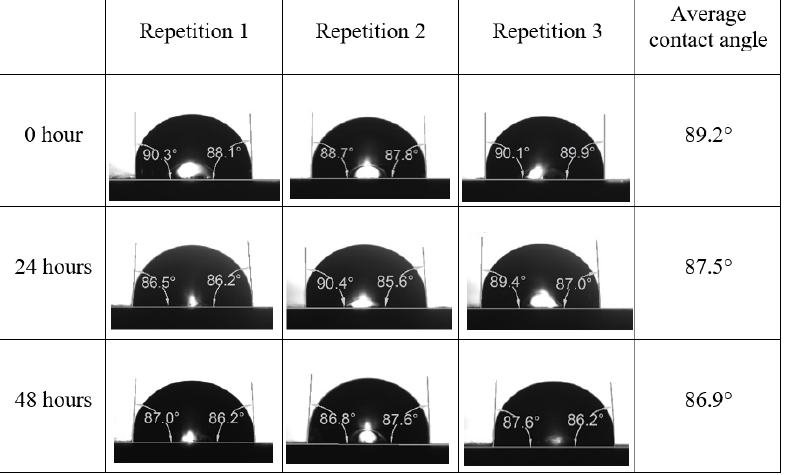
Figure A13. Dynamic Contact Angle Measurement Results for 50% MgCl 2 + 50% CaCl 2 (3500 ppm).